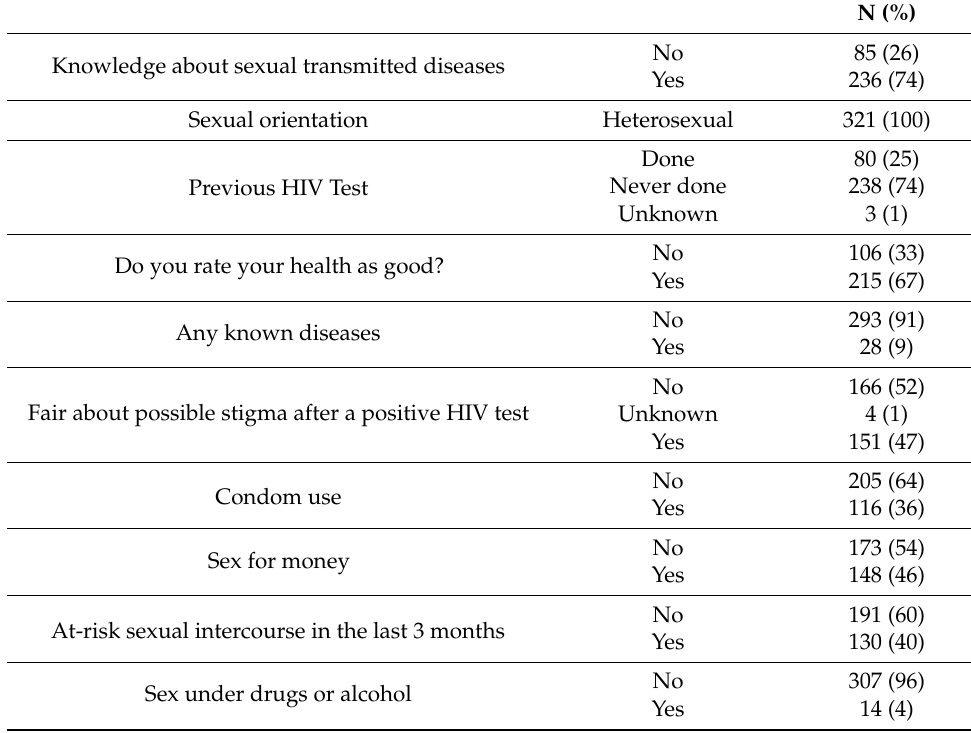
Table 2. Health perceptions and behaviors reported by the 321 migrants enrolled in the study.